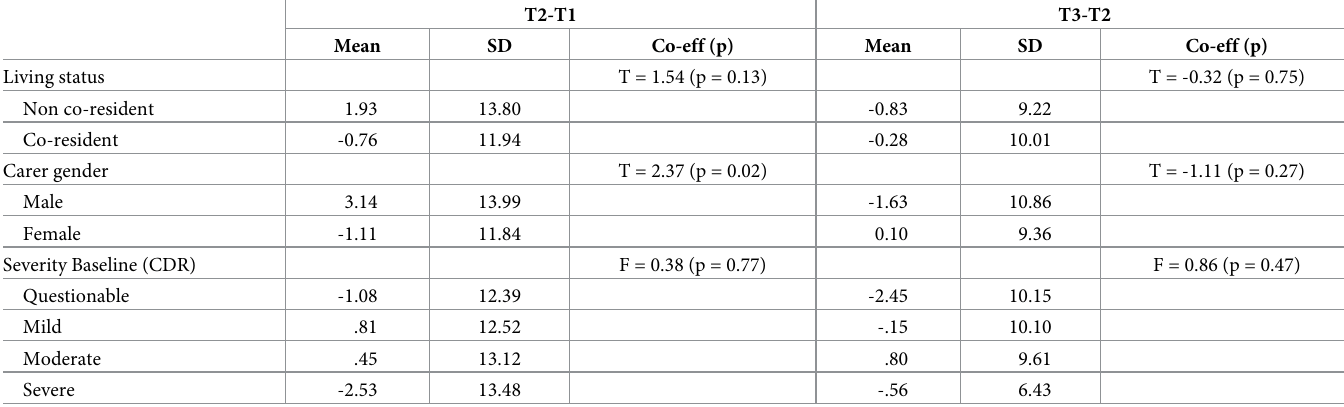
Table 2. Bivariate comparisons of DEMQOL-Proxy (change between time-points).